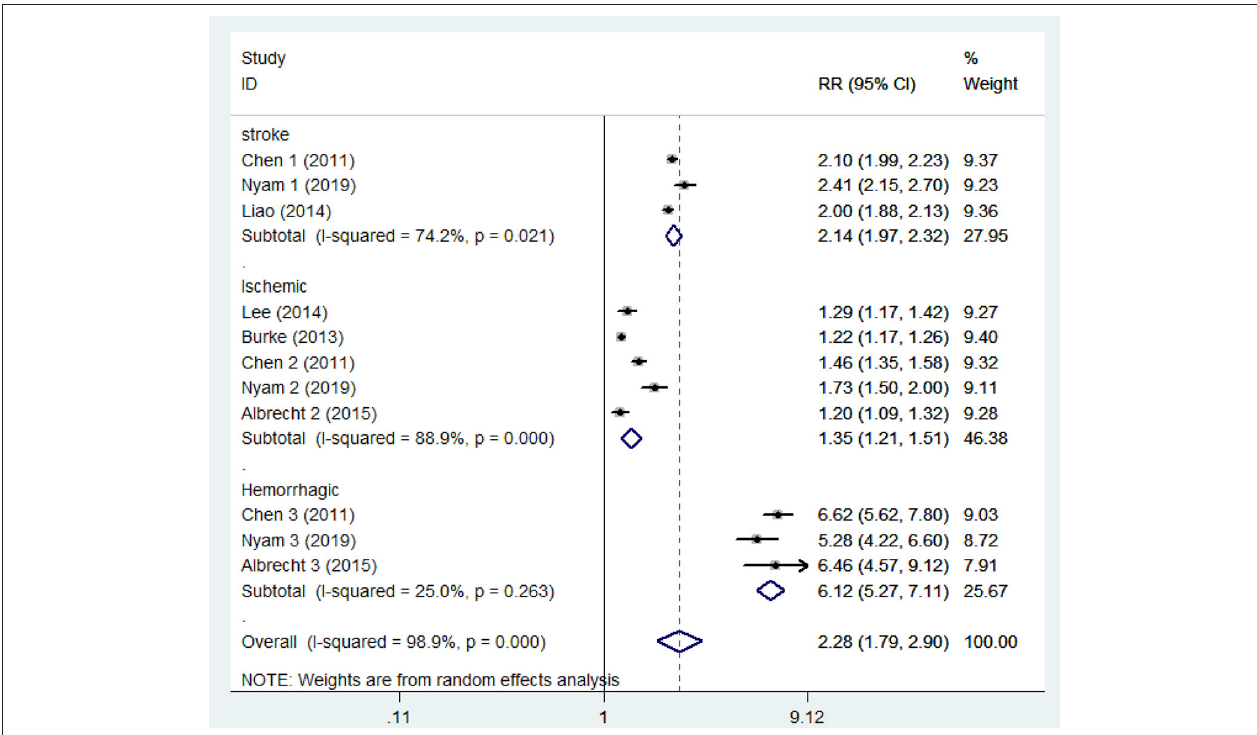
FIGURE 3 | Forest plots of the association between traumatic brain injury and future stroke in all included studies. The meta-analysis was performed using a random-effects model. The subgroup analysis is shown. Diamonds represent the pooled estimates, and the horizontal lines represent the 95% confidence intervals. RR, relative risk; CI, confidence